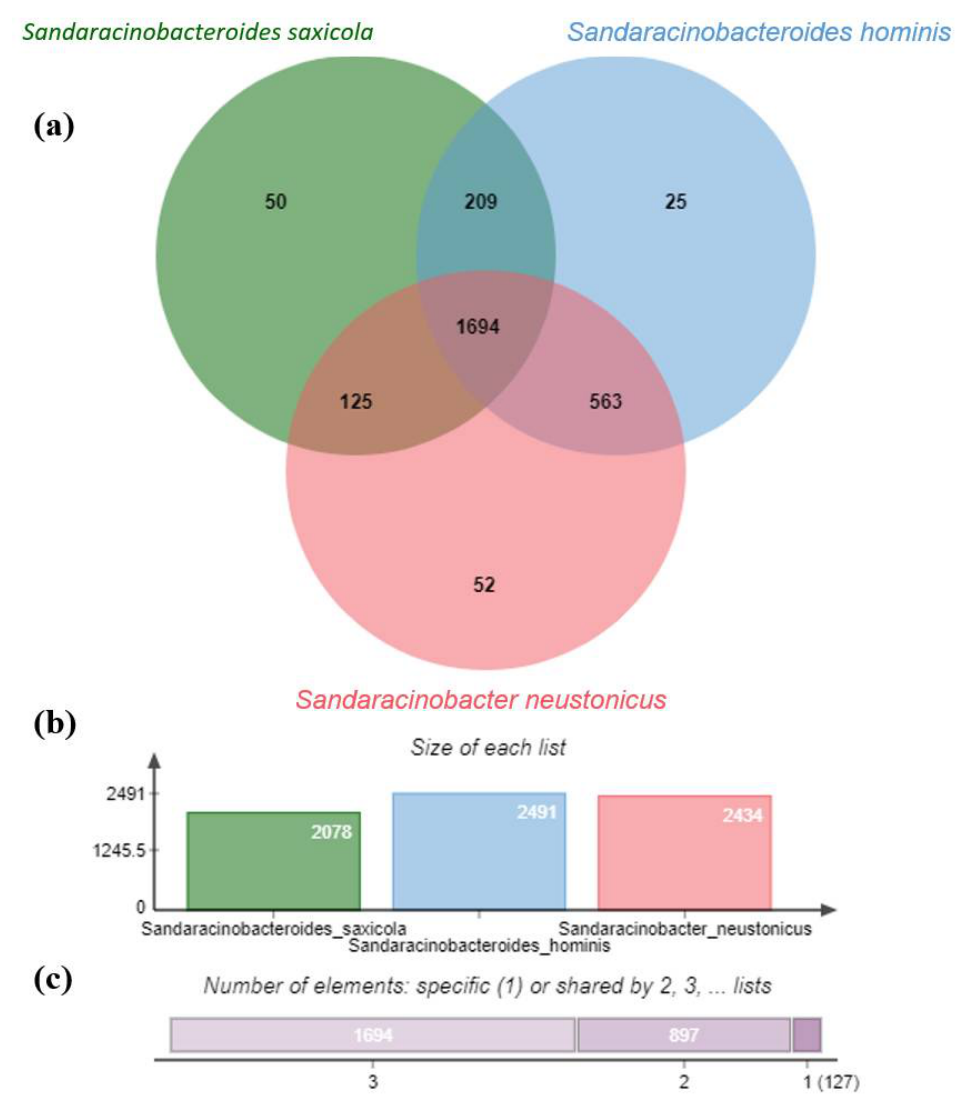
Figure 3. Venn diagram and the bar plots generated by Orthovenn2 represent the distribution of shared and unique gene clusters amongst S. saxicola M6 T , S. hominis SZY PN-1 T , and S. neustonicus PAMC 28131 T . ( a ) The Venn diagram represents the distribution of core ortholog clusters, shared clusters, and unique clusters in all three species. ( b ) The bar plot represents the cumulative ortholog clusters found in each species. ( c ) The bar plot illustrates the cumulative core, shared, and unique clusters in all the three species, where label 1 on the horizontal scale shows the cumulative number of unique clusters (127) for all the three species, while label 2 shows the total number of clusters shared by two species (897) and so on.